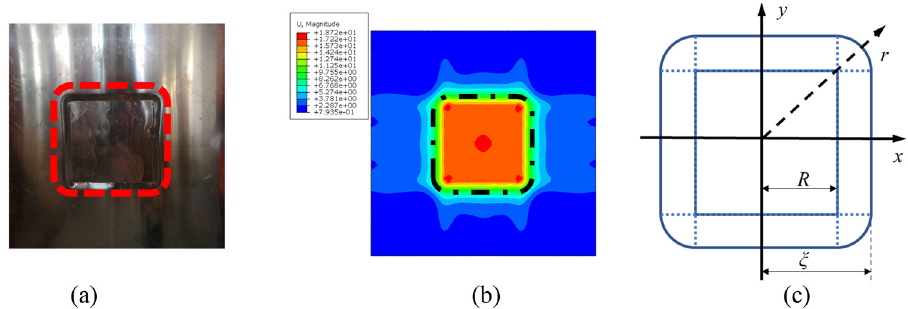
Figure 3: Deformation in concave area by impact pressing. ( a ) Actual deformation. ( b ) FEM deformation. ( c ) Ideal indentation